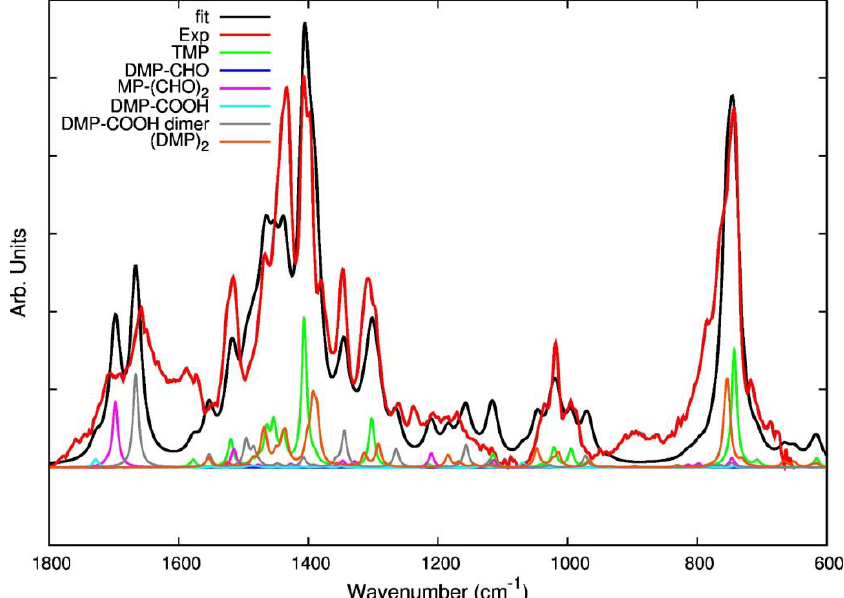
Figure 7. Result of the fitting of the experimental spectrum (red line) of a TMP sample after thermal treatment (reference spectrum of modified TMP (sample treated at 130 °C, spectrum recorded after TMP evaporation). The fitting curve (black line) is obtained as a weighted sum of theoretically predicted spectra for some model molecules (oxidized species and dimer) illustrated in Table 1. The spectra included in the fitting are displayed in different colors: each spectrum is multiplied by a factor proportional to the weight adopted in the fit.